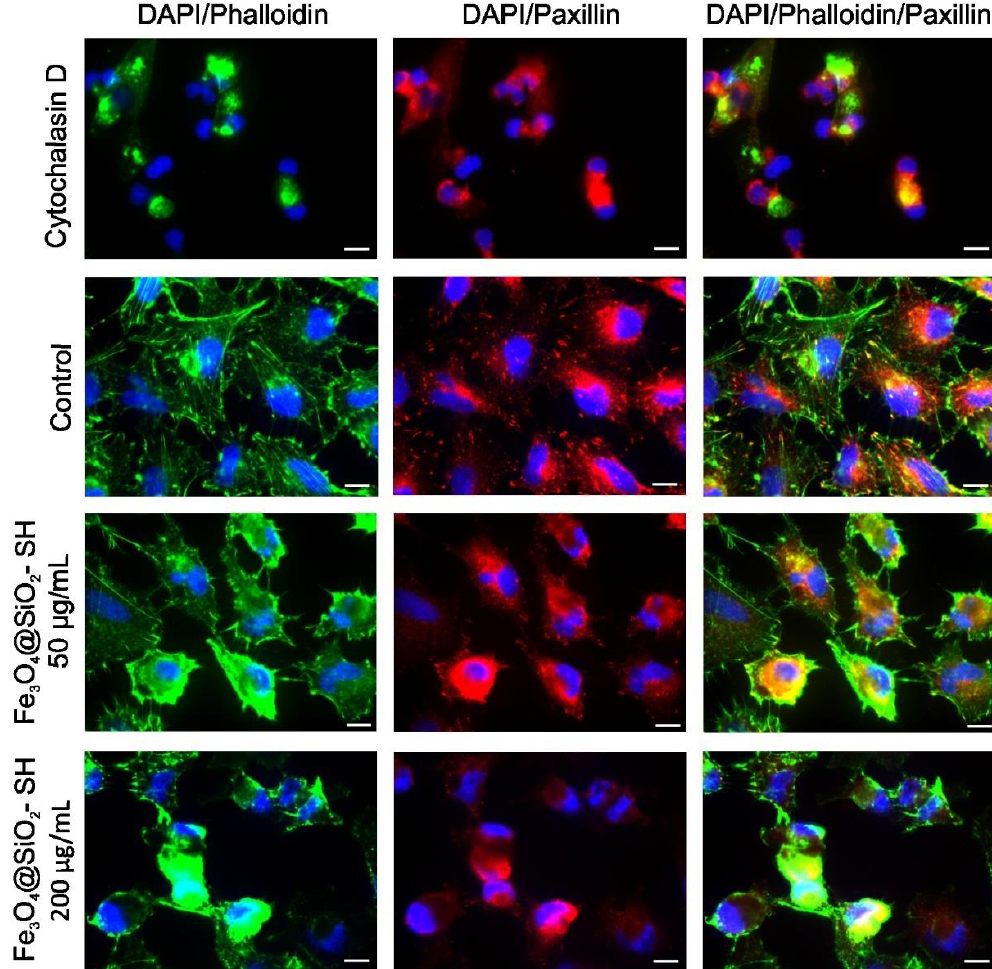
Figure 9. Fluorescent microscopic images of A549 cells stained with Alexa Fluor 488 phalloidin (F-actin, green) and anti-paxillin (red), and counterstained with DAPI (nuclei, blue). The cells were sham-treated with H 2 O (negative control) or treated Fe 3 O 4 @SiO 2 -SH nanoparticles at 50 and 200 µ g / mL. Cells treated with 0.5 µ g / mL of cytochalasin D, a member of the cytochalasin fungal alkaloids that acts as a potent inhibitor of actin polymerization, were used as a reference in this assay. Experiments were performed in triplicates by using epifluorescence microscopy. Photographs from representative chambers are shown. The scale bar in the images represents 10 μm.